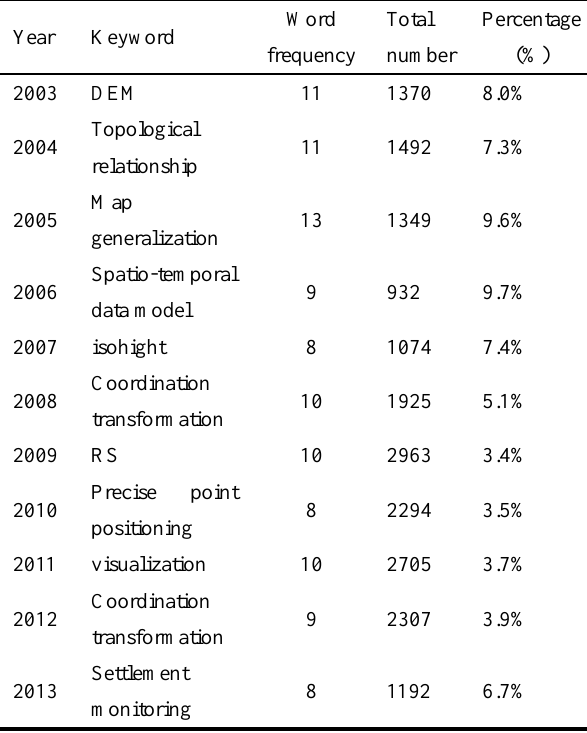
Fig.1 Highest frequency keywords from 2003 to 2013 Figure 2 reflects the frequency and percentage of keywords by year (from2003-2013): broken line represents word frequency, and the bar chart indicates the percentage of this word frequency and all keywords’ amount. What be seen from the chart, is that word frequency and its percentage are basically positively correlated relationship from 2003 to 2007, that is to say, the higher the keyword frequency is, the greater the percentage is.